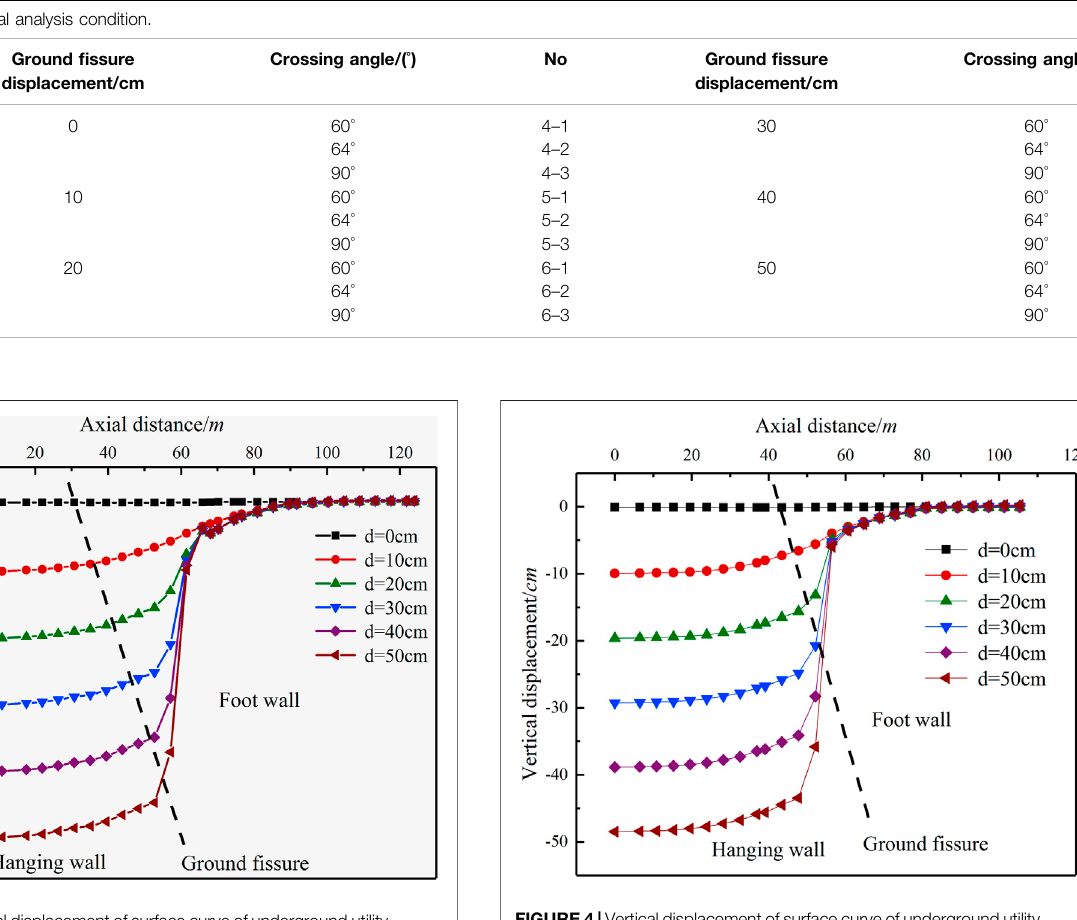
FIGURE 3| Vertical displacement of surface curve ofunderground utility tunnel obliquely crossing the ground fi ssure (inclination 60 ° ).